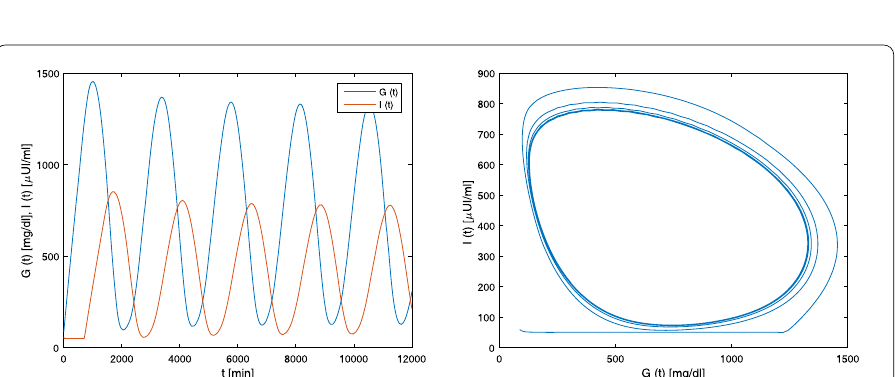
Figure 1 Time series and phase portrait of fractional-order model (29) generated using the information from Set 1, the parameter values in Eq. (58), and τ = 400 < τ 0 = 607.919. The positive equilibrium ( G ∗ , I ∗ ) = (650.592,381.488) of the system is asymptotically stable